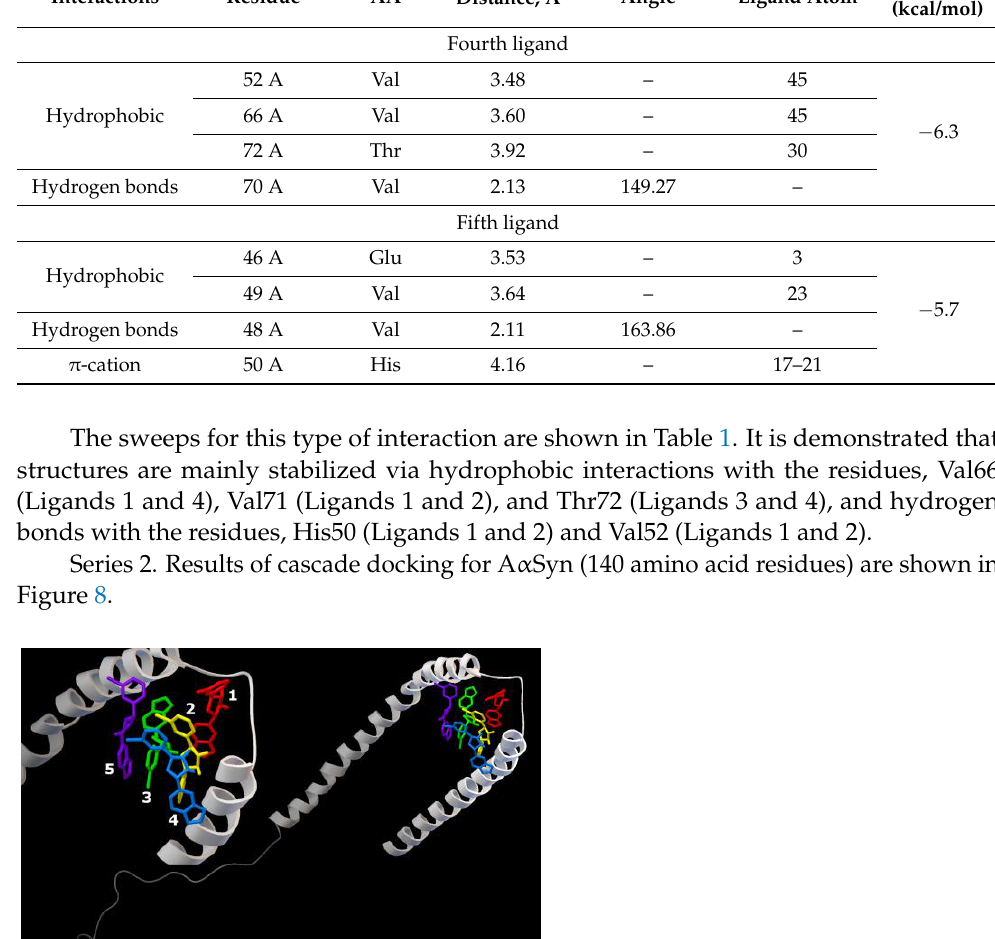
Table 2. Interactions of five Anle138b ligand molecules with micelle-bound AαSyn (PDB ID 1XQ8).